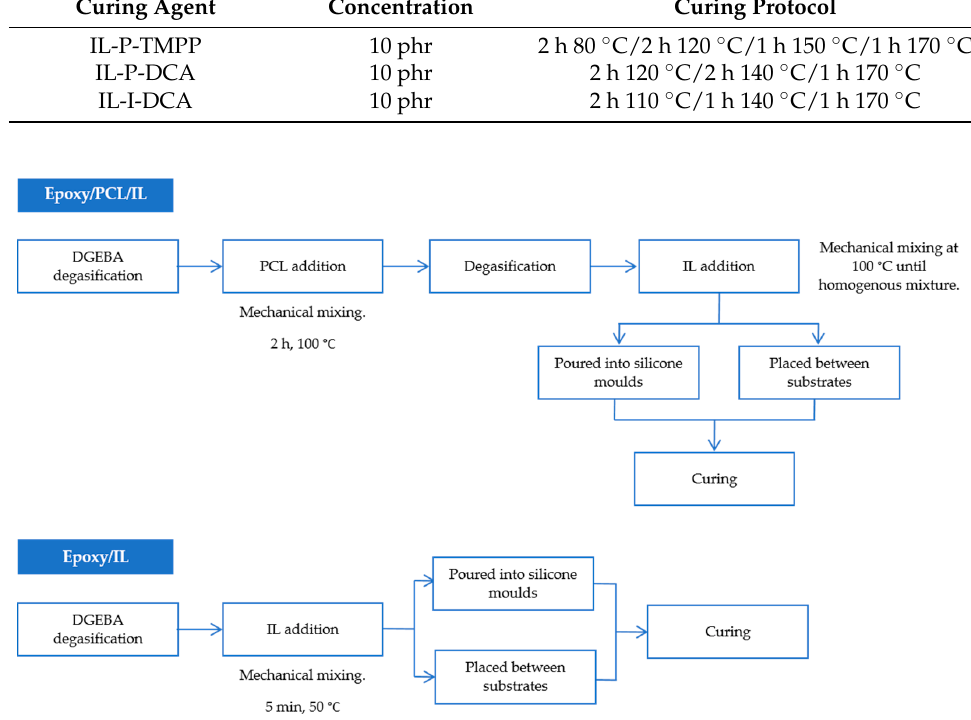
Figure 1. Experimental flowchart for the preparation of the